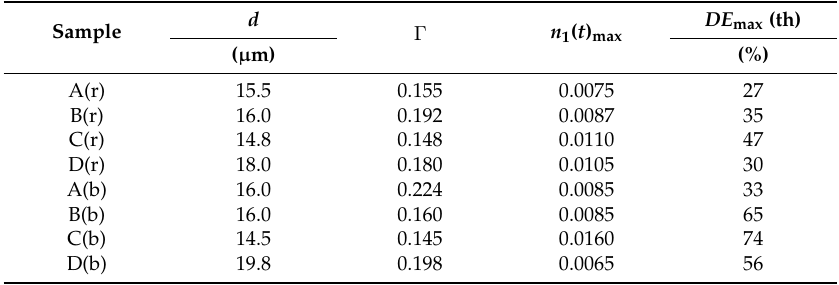
Table 3. Parameters obtained with rigorous coupled wave theory (RCW).